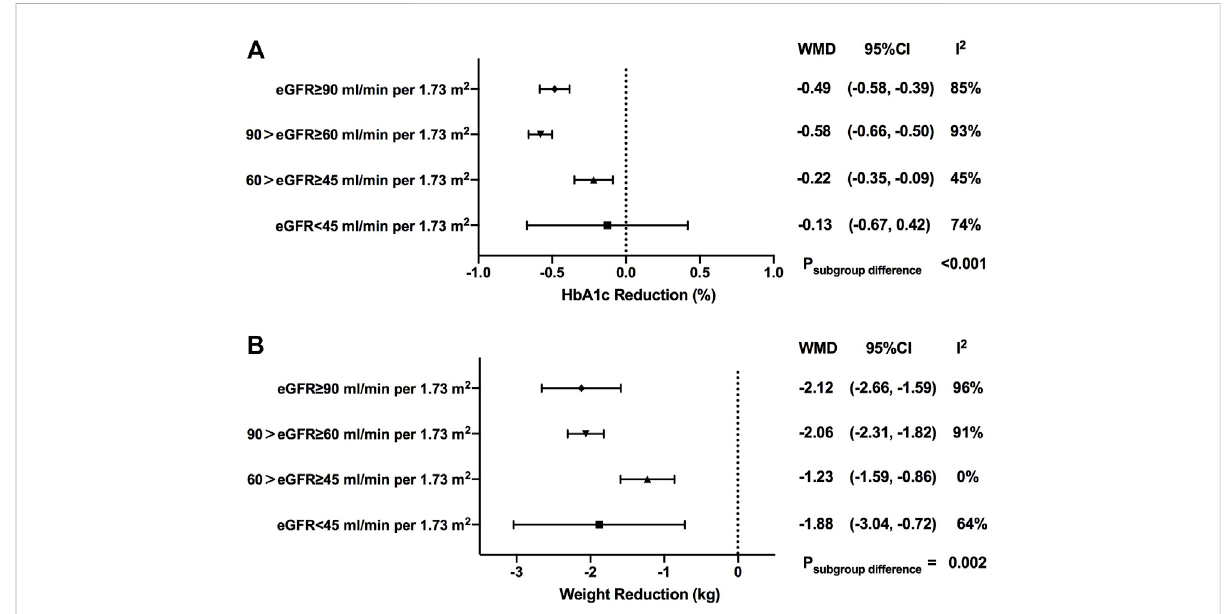
FIGURE 2 HbA1c and weight changes of SGLT2i treatment in patients with different levels of renal function. HbA1c, glycosylated hemoglobin; eGFR, estimated glomerular fi ltrationrate; WMD, weighted mean differences; 95% CIs, 95% con fi dence